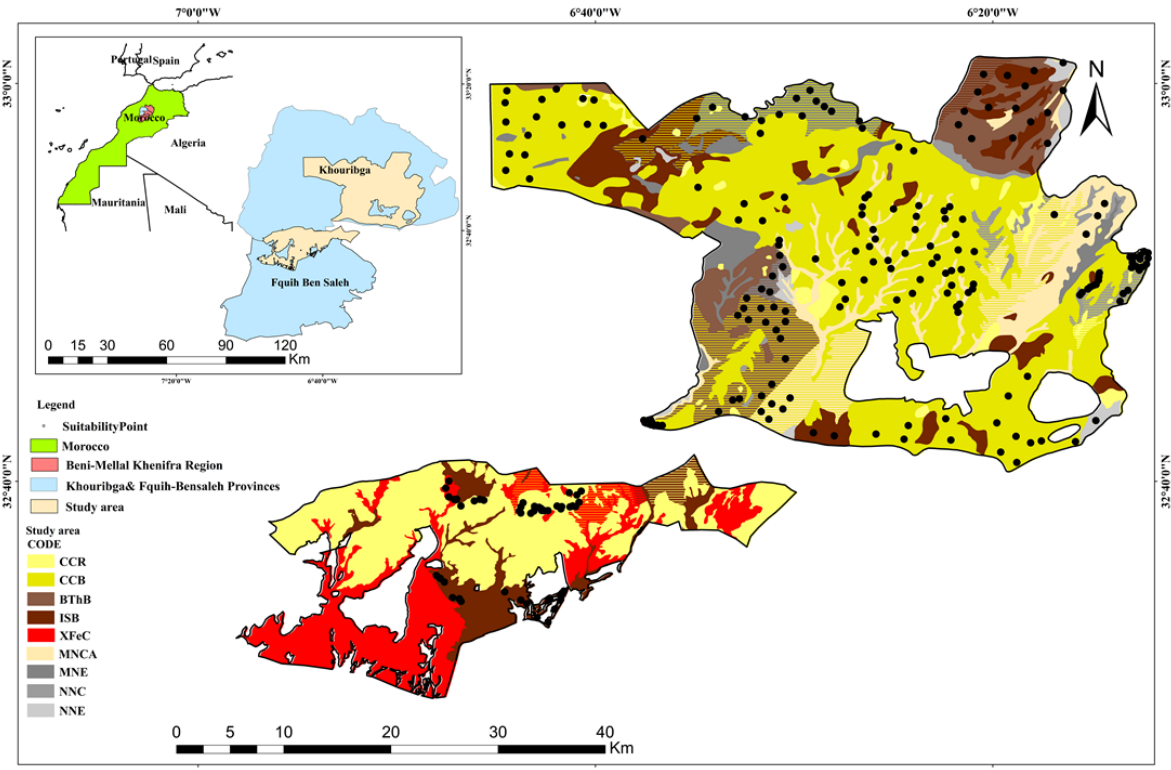
Figure 1. Location of the study area and soil type. BThB: Browned soils, CCB: Calci-magnesic Limestone browns soils, CCR: Calci-magnesicrendzines soils, ISB: isohumic soils, NNCA: Little evolved soils, MNE: Raw mineral soils, NNC: Little evolved soils Of colluvial contribution, NNE: Little evolved soils Erosion, XFeC: iron sesquioxide soils.